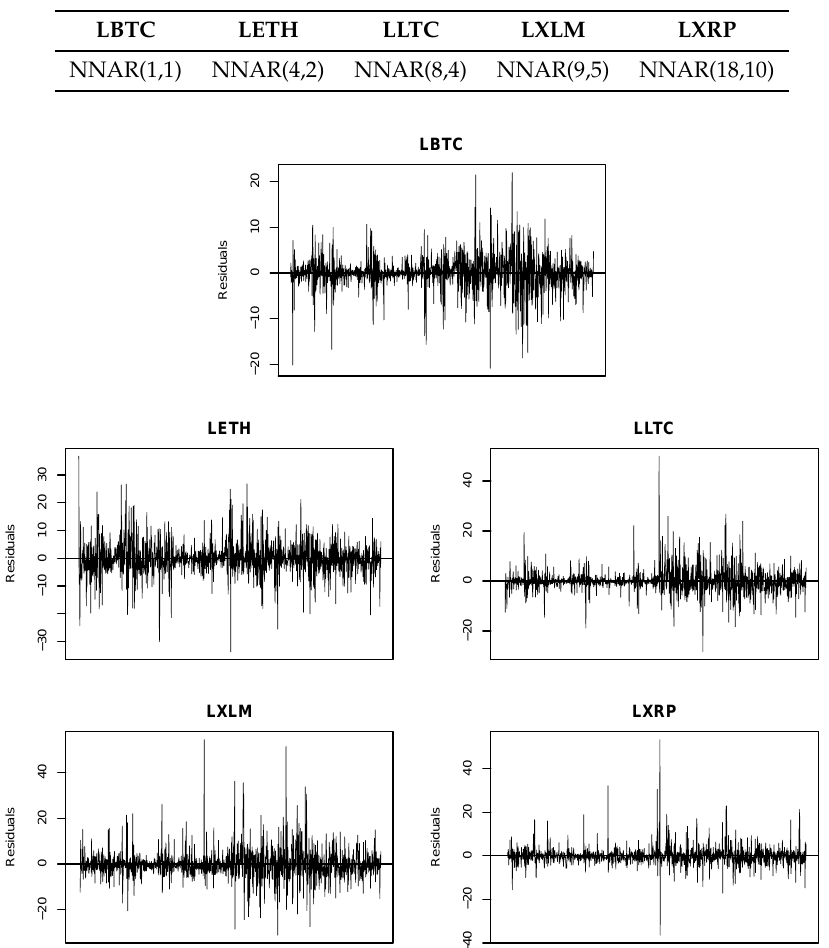
Table 3. The Optimal model structure using neural networks autoregression models, NNAR ( p , k ) . This table shows the optimal model structure of estimating nonlinear autocorrelations in log-returns of five cryptocurrencies. The p and k represent the lags and hidden nodes, respectively, used in the model.